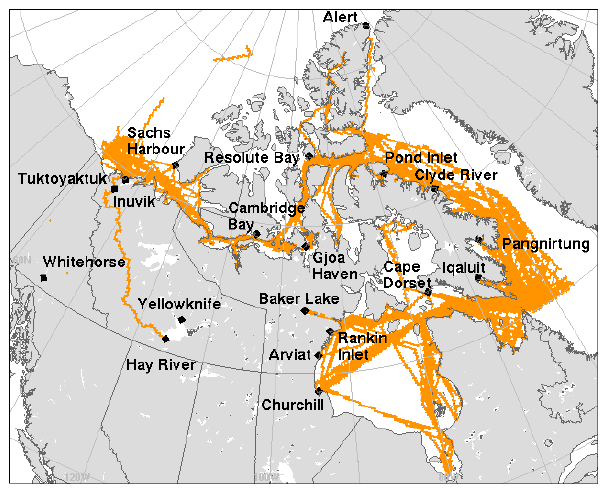
Figure 1. 2010 vessel movements in Canada’s